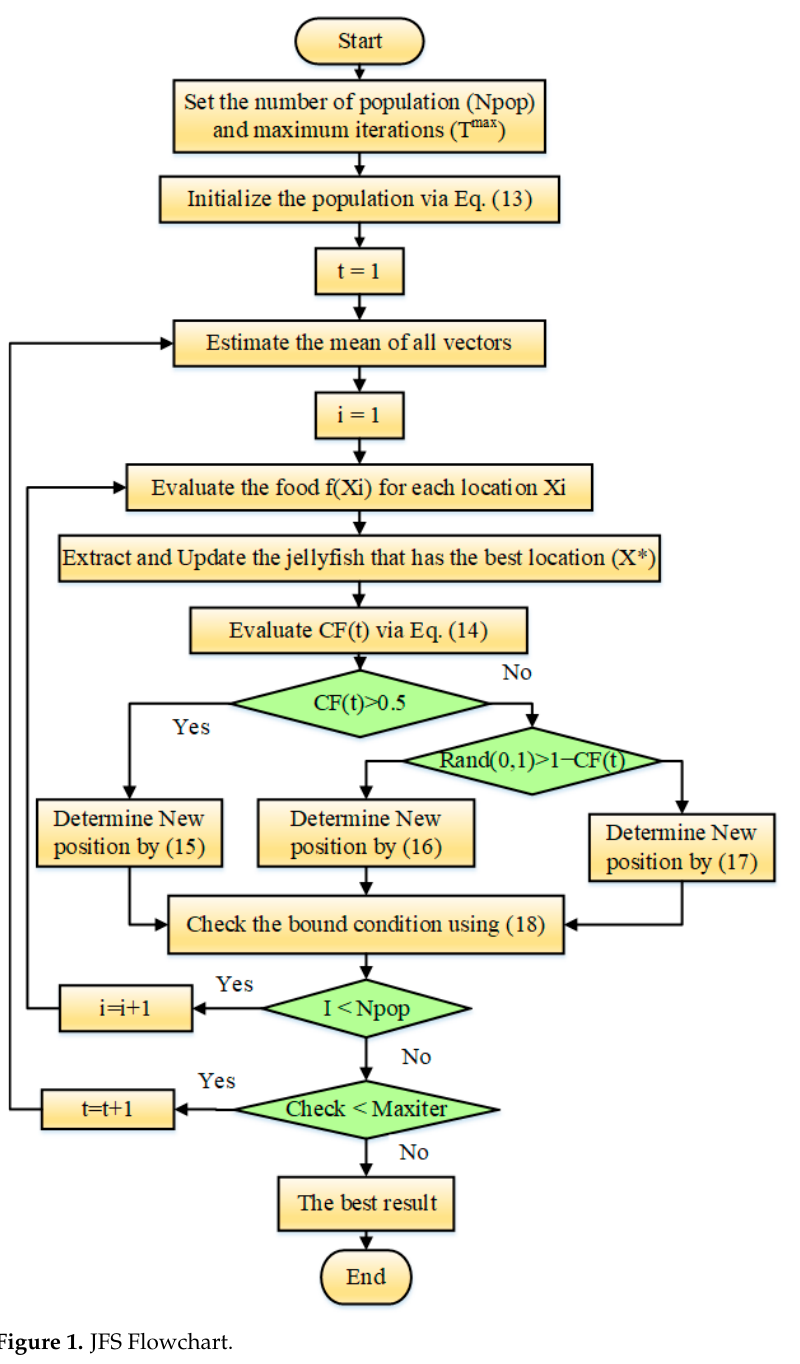
Figure 1. JFS Flowchart.